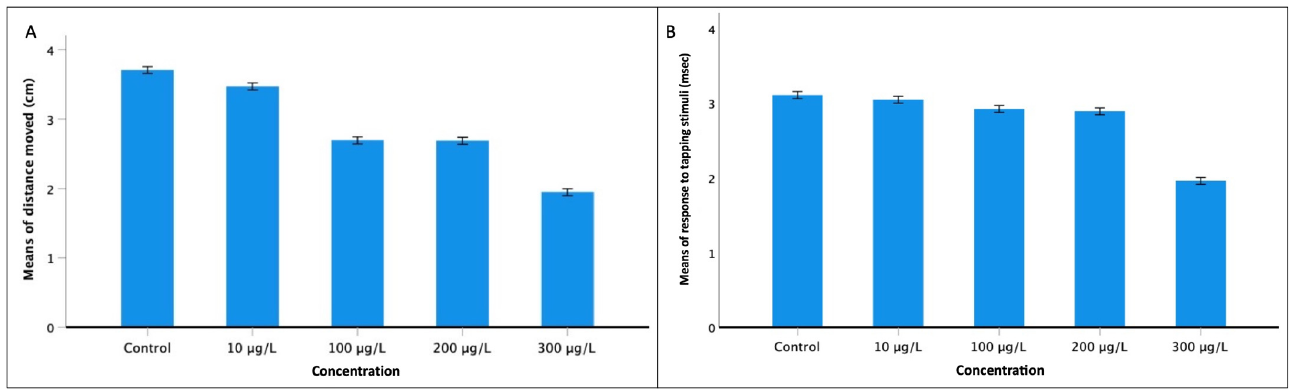
Figure 5. Distance moved (in cm) for 10 s after a stimulus delivery ( A ) and response time (in 10 − 3 s) after a stimulus ( B ) on zebrafish larvae exposed to various concentrations of